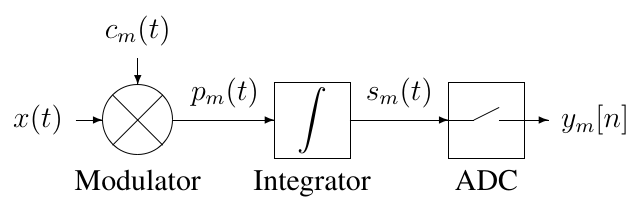
Figure 2. Block diagram of the